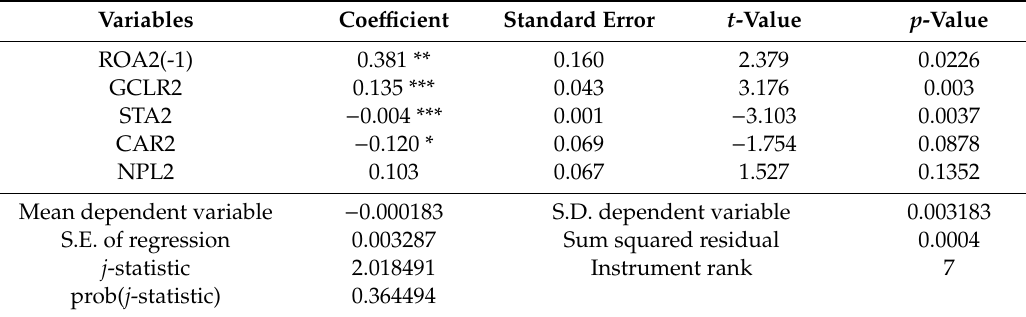
Table 4. Model 2 regression results for international commercial